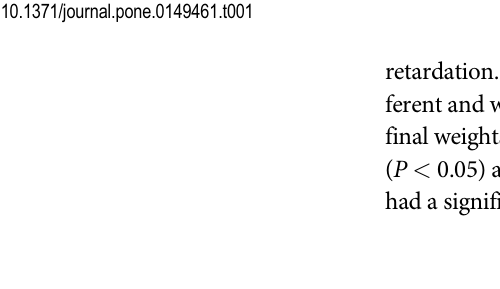
retardation. (Table 4) The initial weight of the yaks in NG, GG and CG were not significantly dif- ferent and were significantly less than those in the PG ( P < 0.05). After 84 days of feeding, the final weights of the yaks in the GG and CG were significantly more than that in the NG ( P < 0.05) and were close to the weight of normal yaks ( P > 0.05). The yaks in the GG and CG had a significantly higher ADG than the NG and PG throughout the study ( P < 0.05). The ADG